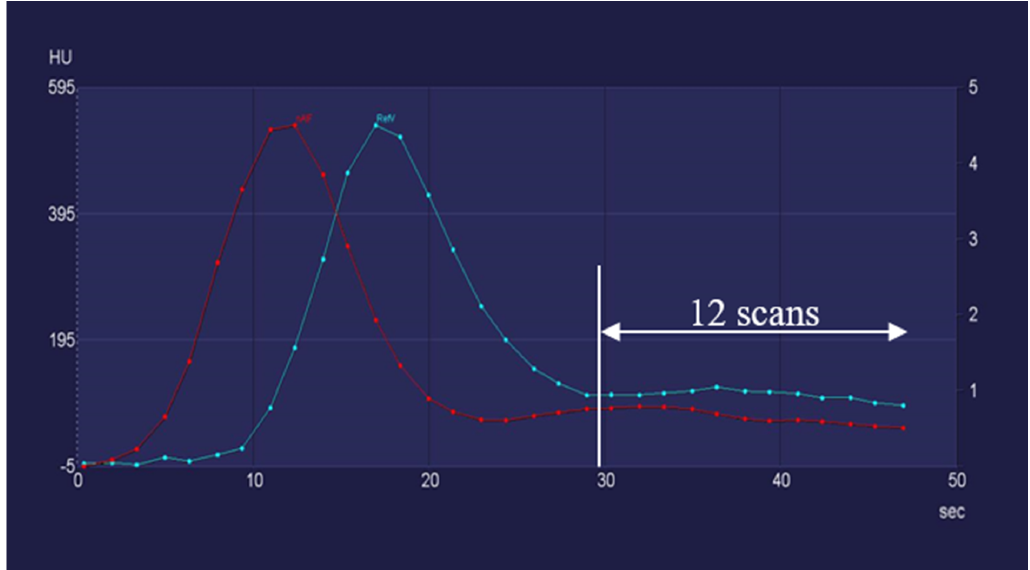
Figure 4. In patients with a fast bolus arrival, the number of scans could be decreased to 20. Our correlation analysis indicates a strong relationship between a fast aortal bolus arrival and a fast wash-in phase and an early arterial inflow peak and a fast wash-out phase.